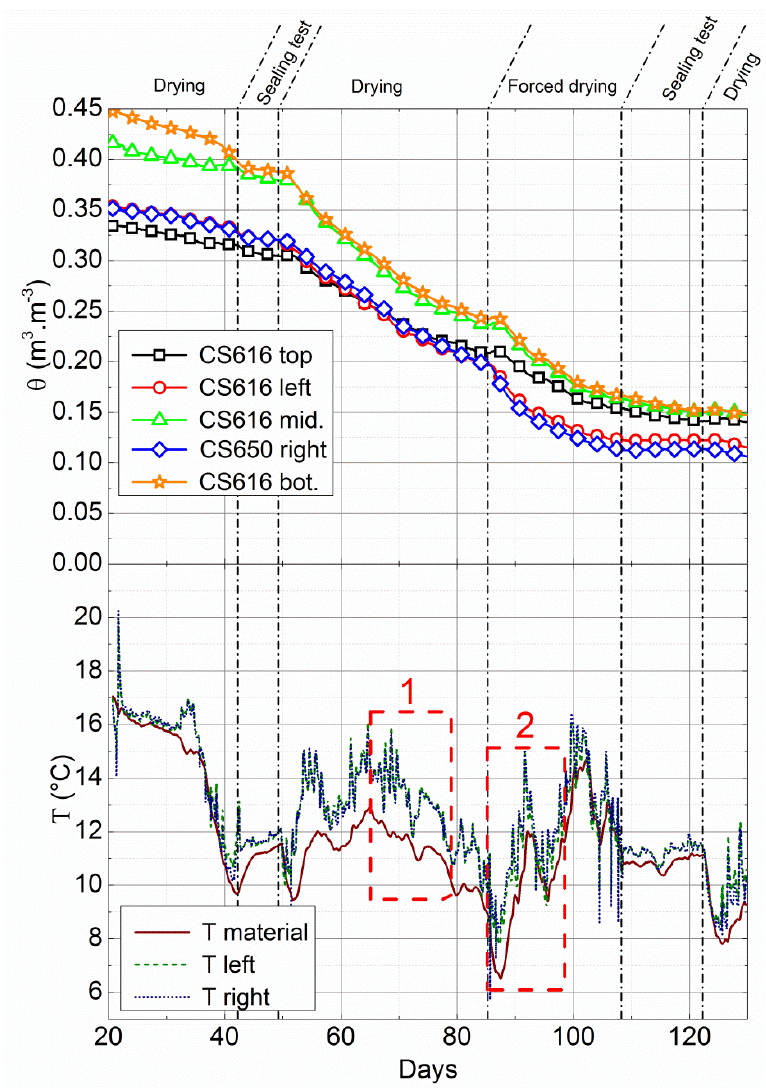
Figure 5. Evolution of (up) volumetric water content and (down) temperature of the